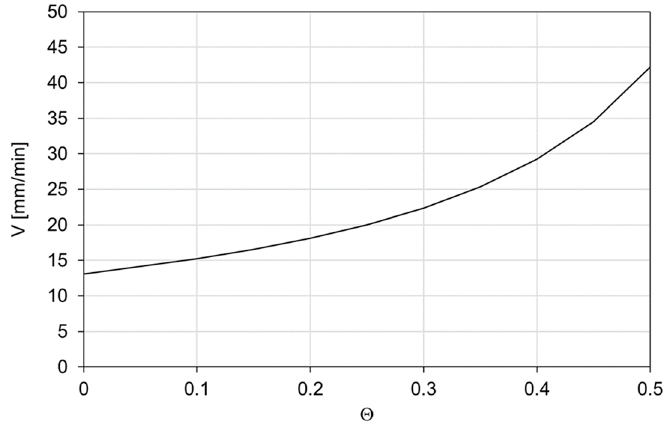
Figure 3. Maximum critical growth rate V cr for a stable interface in dependence on the kinetic factor Θ for As-doped silicon with k = 0.35, C L = 1 × 10 20 at/cm − 3 , and G = 350 K/cm calculated by Equation (6).